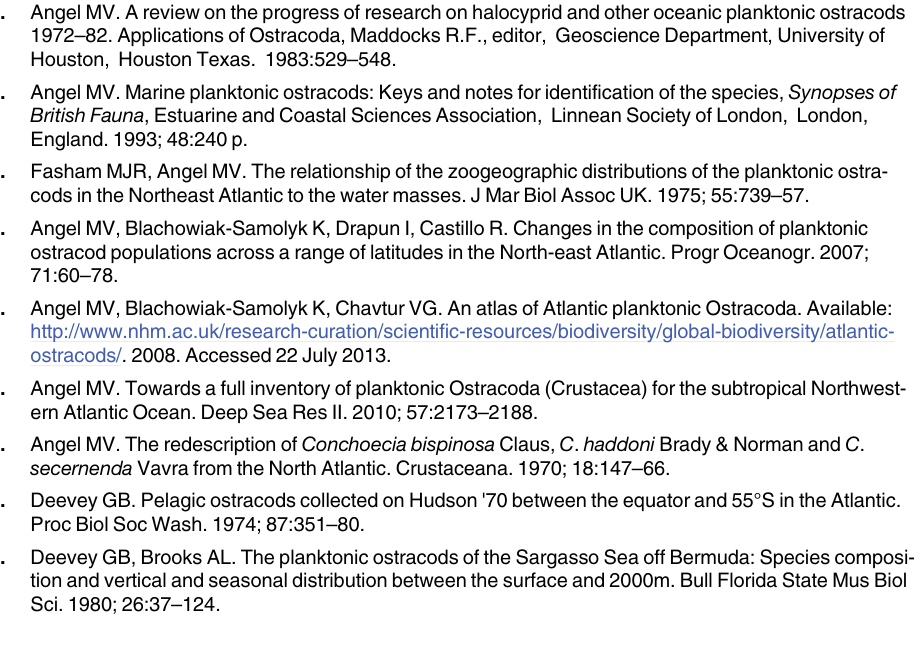
S1 Table. Collection information and metadata for specimens of marine planktonic ostra- cods analyzed for this study. All specimens analyzed are listed by species name, with DNA voucher numbers, GenBank Accession Numbers, and collection information (date, latitude and longitude, ocean region and cruise). Additional metadata are included in each GenBank